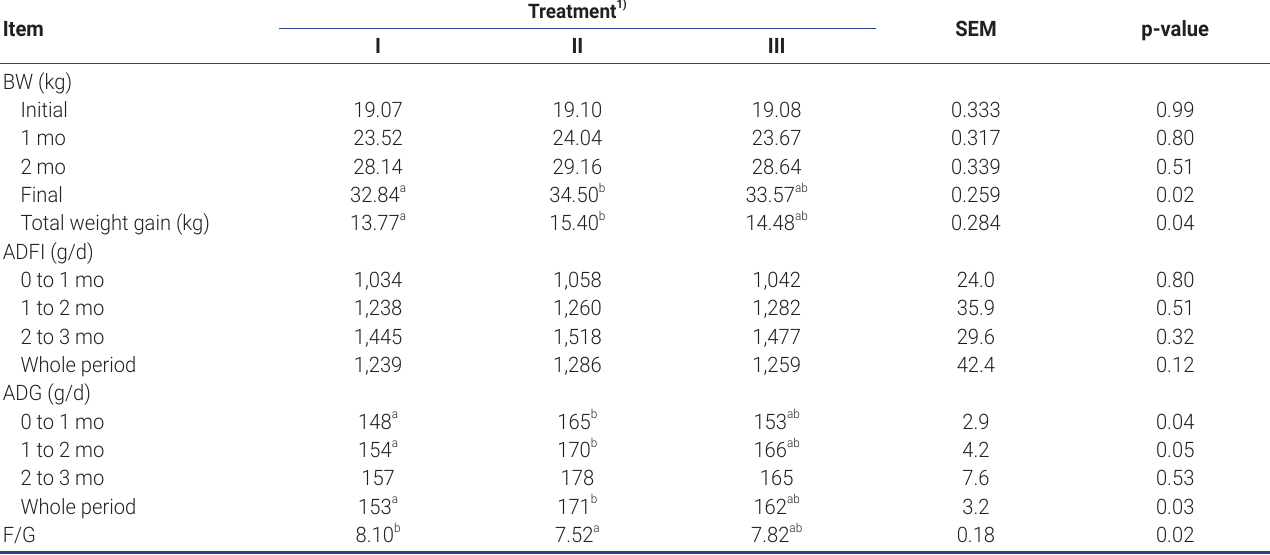
Table 2. Effect of dietary GAA and RPM supplementation on growth performance of lambs